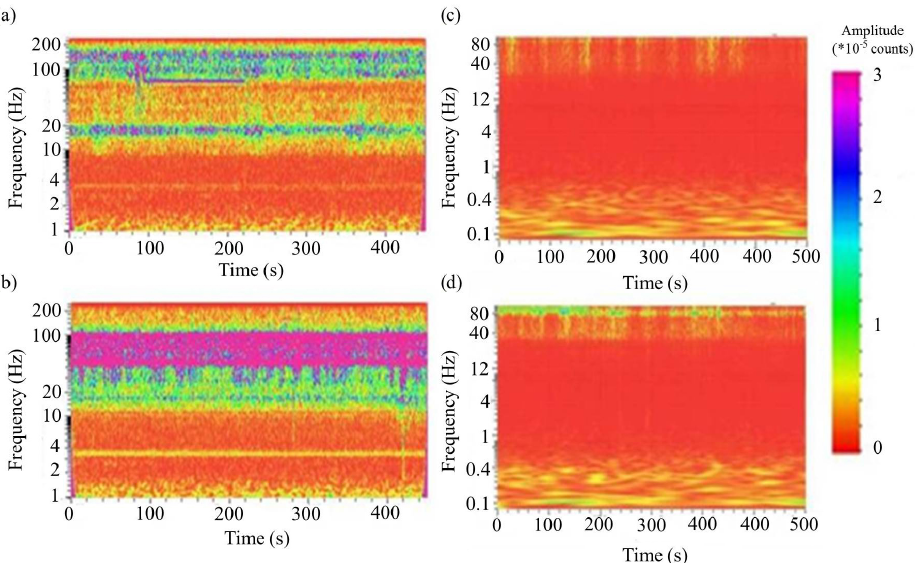
Figure 3. Result of time–frequency analysis of seismic noise recorded by the sensor (a) the most distant from the mine in the Pyhäsalmi experiment, (b) closest to the mine in the Pyhäsalmi experiment, (c) most distant from a noise source (river) (KU05) in the large-aperture array in the Kuusamo experiment, and (d) KU02, which is closest to the river in the large-aperture array in the Kuusamo experiment.